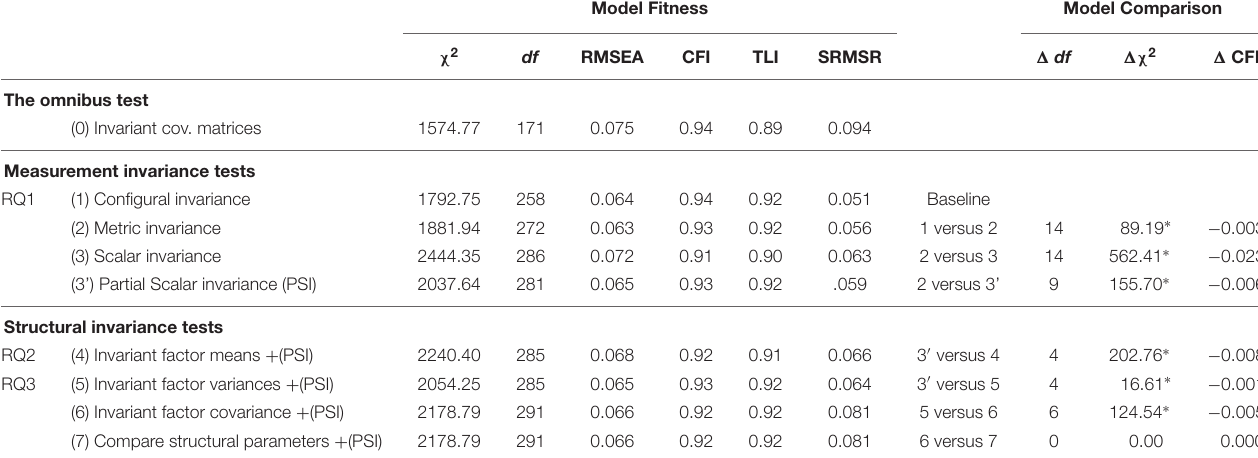
TABLE 5 | Invariance tests across mainland China (ML) and Hong Kong (HK). Model Fitness Model